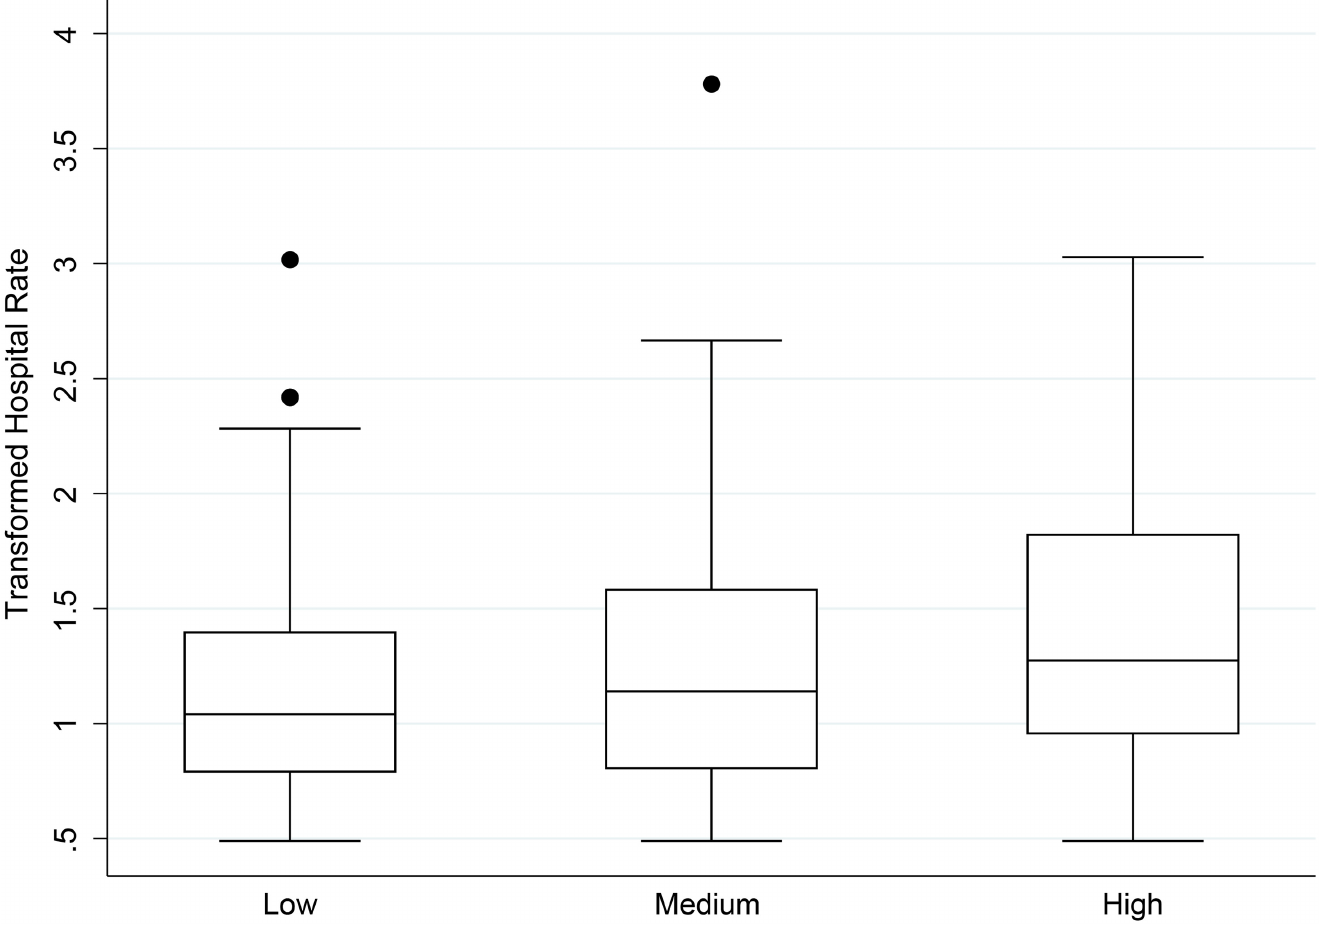
Fig 3. Box plots of hospital diarrhea rates per week per village cluster per 1,000 people by community health rate categories a . Dots represent outliers in the